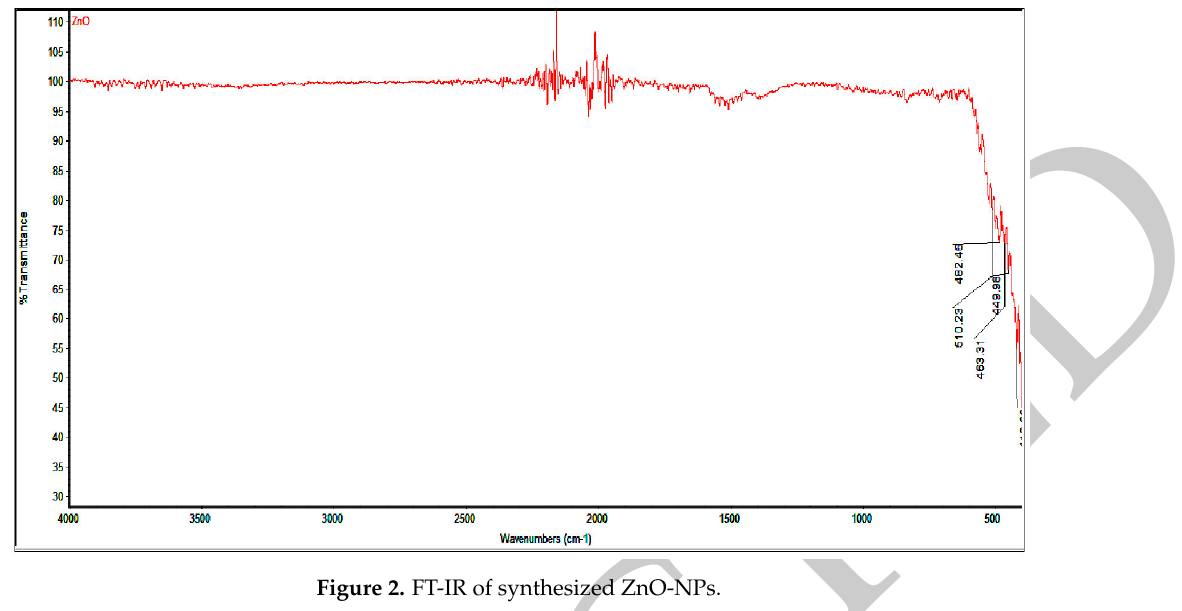
Figure 2. FT-IR of synthesized ZnO-NPs.